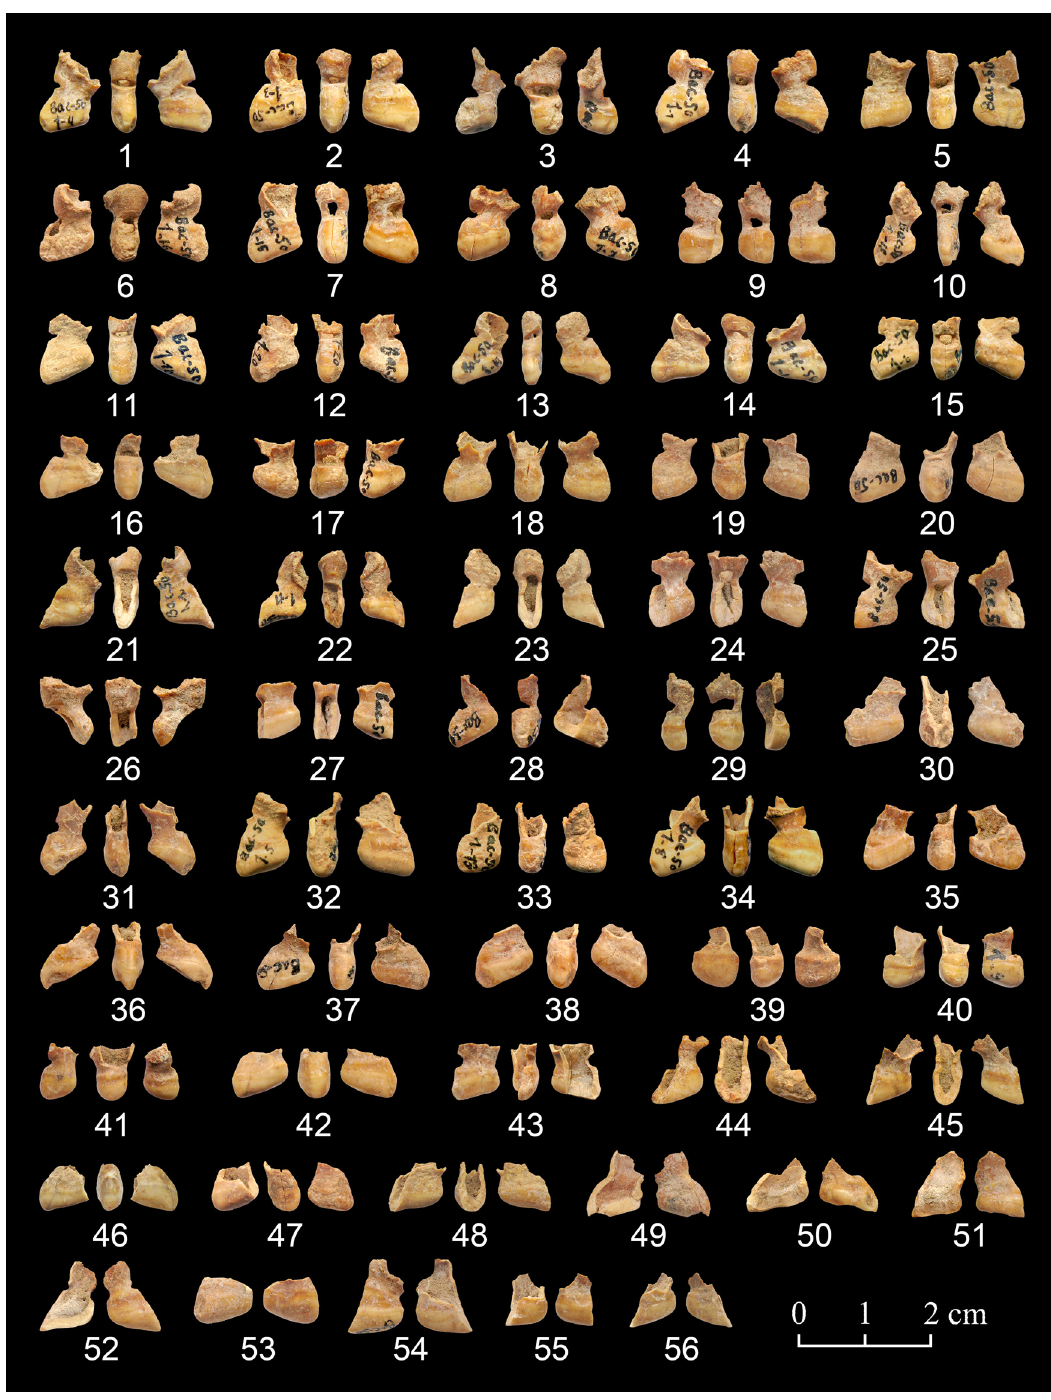
Figure 4: Vasylivka II. Pendants of cyprinids pharyngeal teeth ( 1 – 56 ) from burial No. 1. Photo by D.